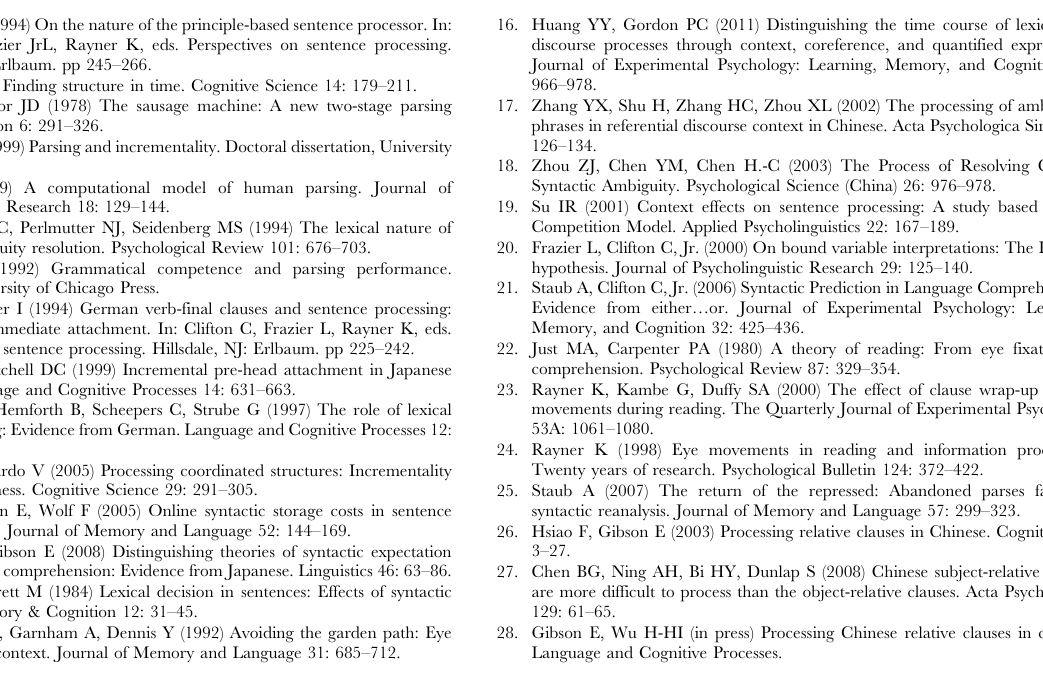
Figure S1 Postulated stages in the parser’s analysis of coordinate